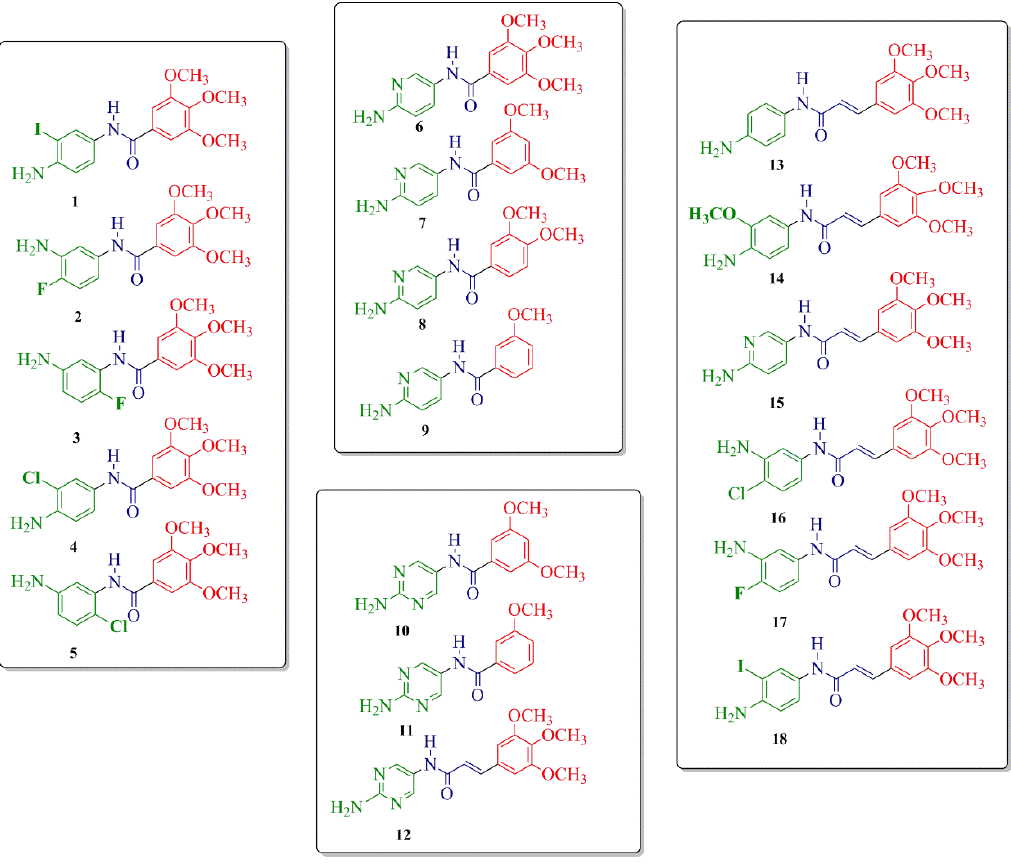
Figure 4. Structures of 1 – 18 novel TMP derivatives.